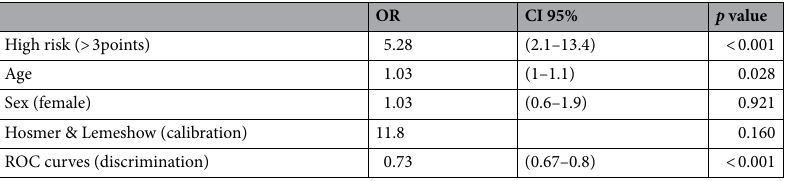
Table 4. Risk of MACE adjusted by age and sex. The AUC of HEART score was 0.73 (95% confidence interval 0.67–0.8). High Risk ORwas 5.28 (95% confidence interval) and a p -value < 0.001, the age was the main risk factor with a OR 1.03 p -value 0.028. MACE Major adverse cardiovascular events, OR Odds ratio, CI Confidence